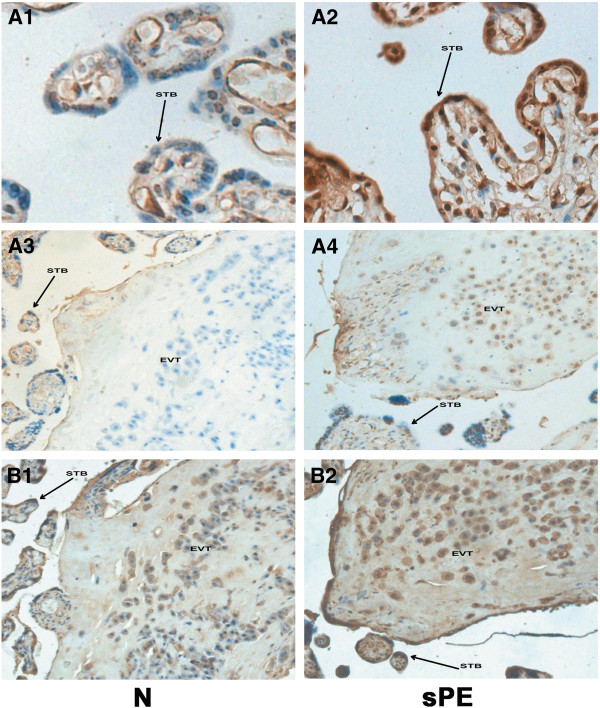
Immunostaining of DKK1 in the placental tissue sections from normal and severe preeclampsia groups. Figure 
4 A1 and A3 show the immunostaining of the DKK1 in normal control (N) group; A2 and A4 show the immunostaining of the DKK1 in severe preeclampsia (sPE) group. The staining intensity of DKK1 in the placental tissue of the severe PE group (A2 and A4) was greater than the control group (A1 and A3). B1 and B2: serial sections of A3 and A4 stained with HLA-G. STB = syncytiotrophoblast, EVT = extravillous trophoblast. Original magnification: 400× for A1 and A2, 200× for A3, A4, B1, B2.